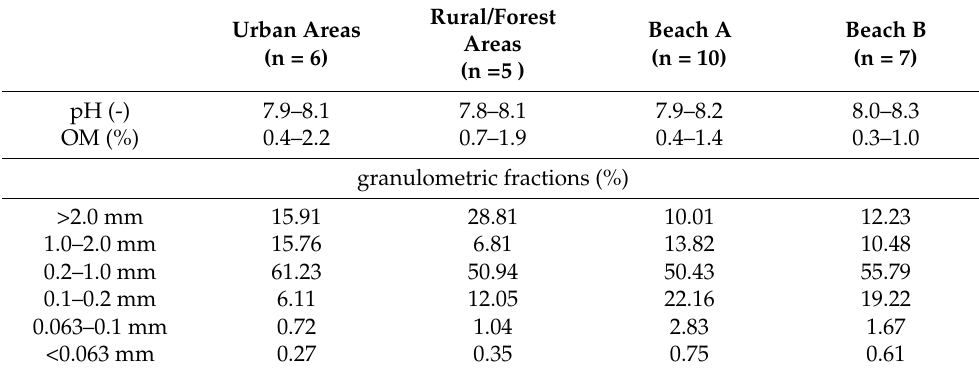
Table 2. Selected parameters of coastal sediments of Ełckie